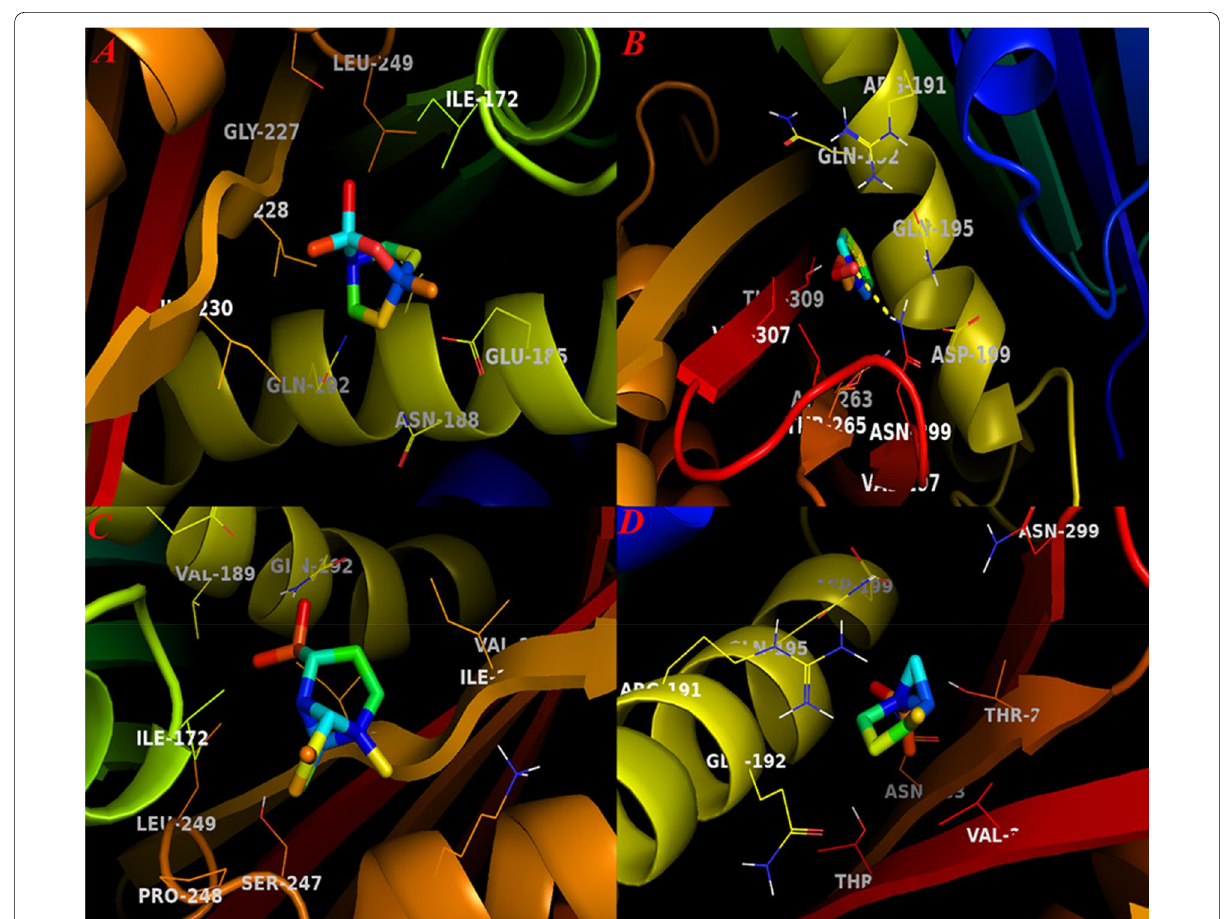
Fig. 5 Graphical illustration docked compounds and FtsZ active site. A 1,8-cineole; B E-cinnamaldehyde; C Copaene and D